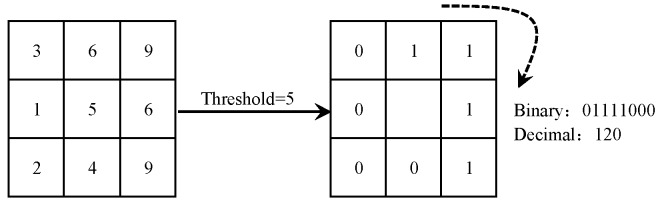
An example of LBP.